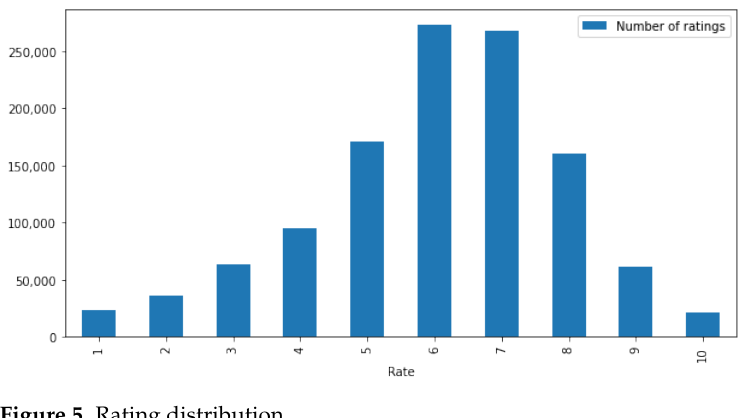
Figure 5. Rating